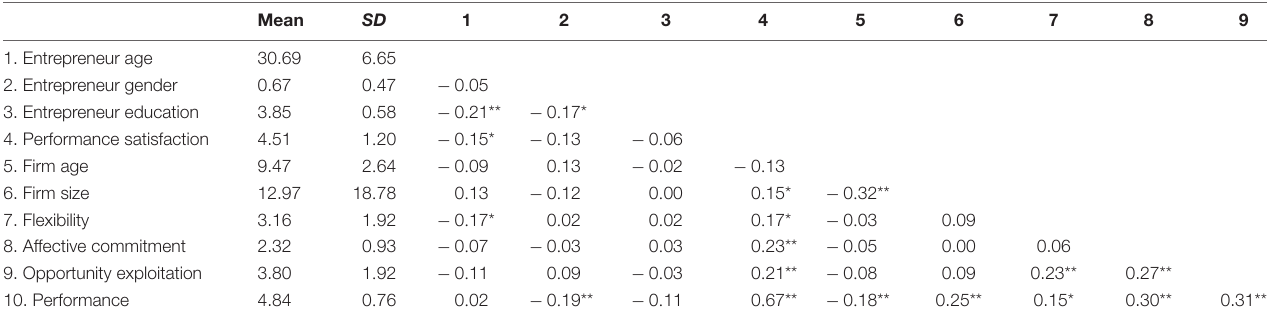
TABLE 1 | Means, standard deviations, and correlations.